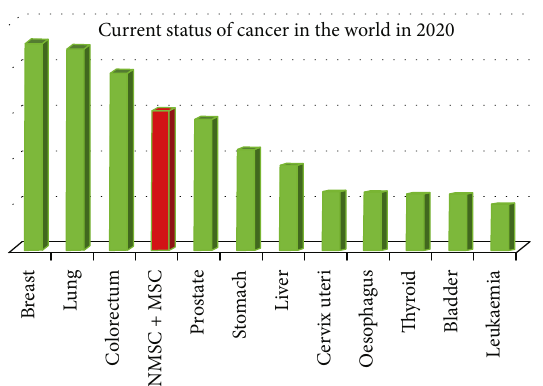
Figure 1: Di ff erent cancer cases in 2020 worldwide (Source: [1]).